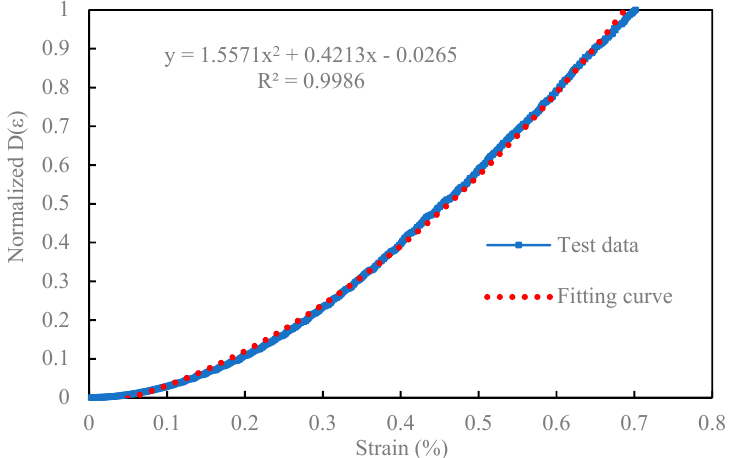
Figure 5. The normalized damage density versus strain curve from the LAS test.